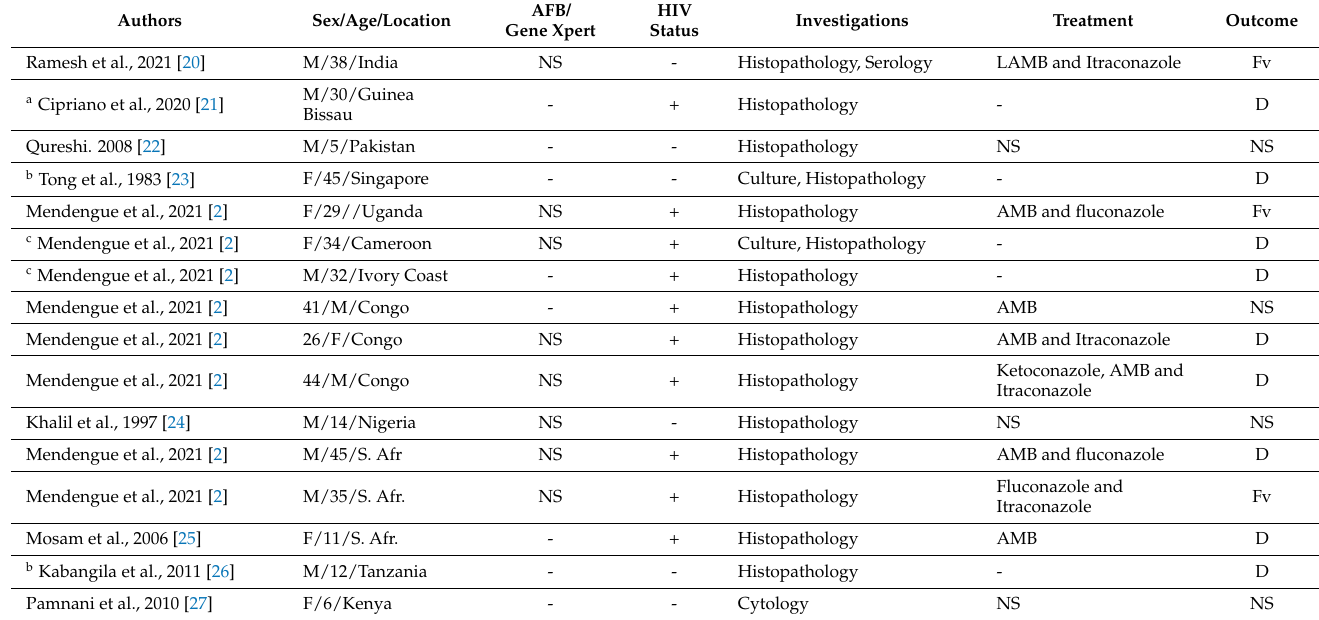
Table 3. Cases of histoplasmosis misdiagnosed as